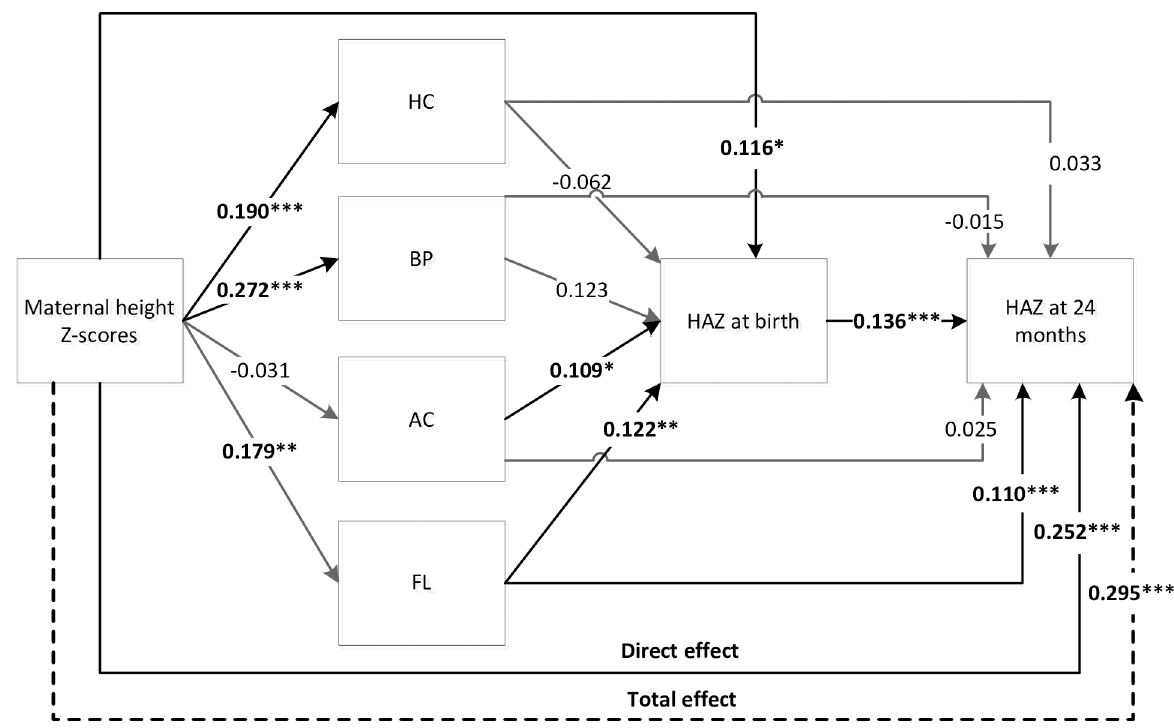
Fig 2. Direct and indirect effects of maternal height Z-scores on offspring HAZ at 2 years. Direct and indirect effects of maternal height Z- scores on offspring HAZ at 2 years. AC, abdomen circumference, BP, Biparietal diameter; FL, femoral length; HAZ, height for age Z-score; HC, head circumference. Significant differences from two-tailed tests: (cid:3)(cid:3)(cid:3) p < 0.001, (cid:3)(cid:3) p < 0.01, (cid:3) p < 0.05. Total effects: 0.30 SD (cid:3)(cid:3)(cid:3) (including direct 0.25 SD (cid:3)(cid:3)(cid:3) and indirect 0.04 SD (cid:3)(cid:3) effects).